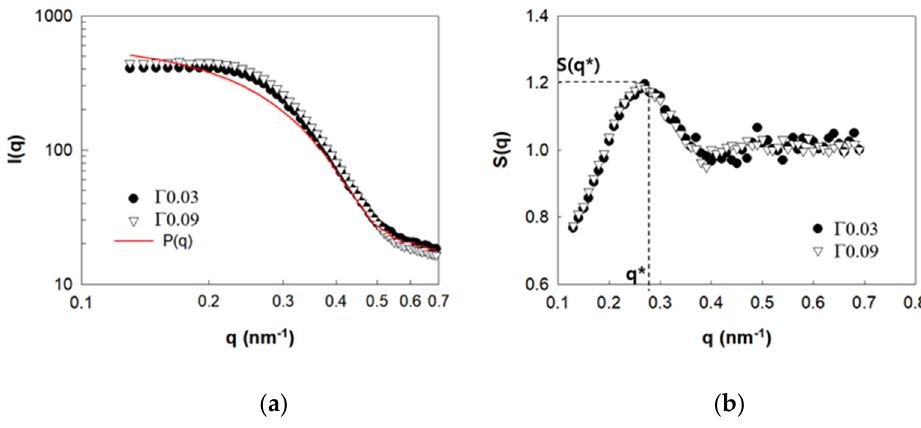
Figure 2. SAXS analysis results of Γ 0.03 and Γ 0.09. ( a ) I(q) and P(q), ( b ) S(q*).